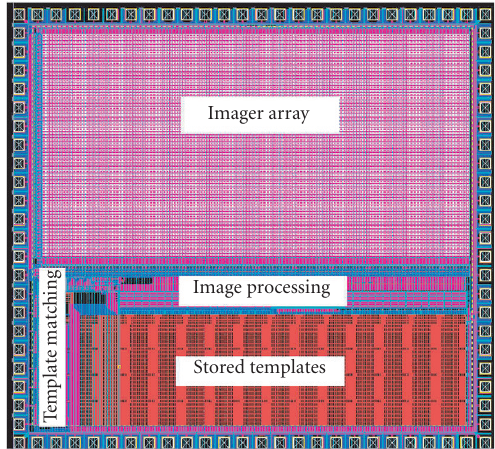
Figure 6: Chip layout (light shield layer obscures all details in mi- crograph).